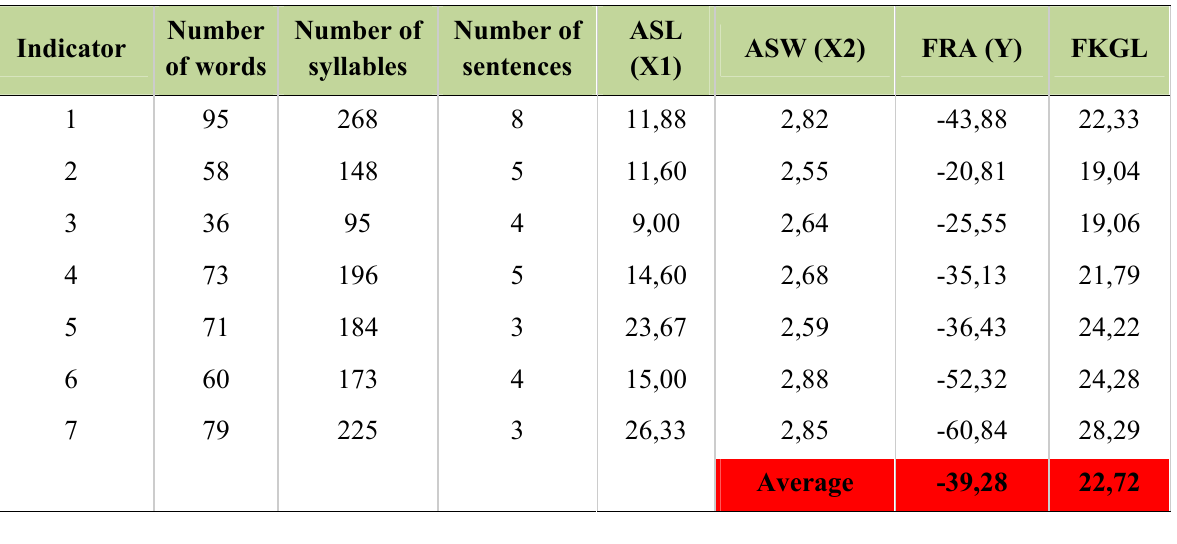
Table 6. Result of SWCSF